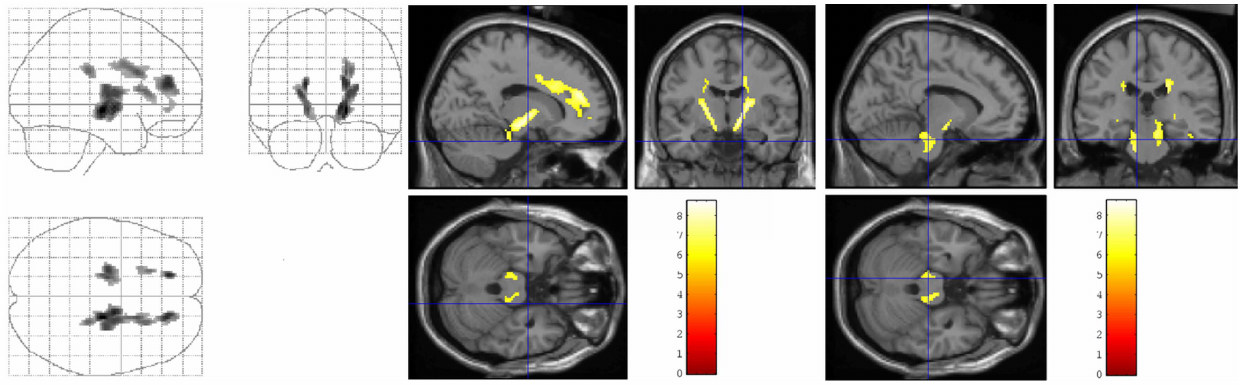
Figure 2. Brain regions in which microstructural lesions were associated with the severity of CSR in patients with CSA. SPM ‘‘glass brain’’ presentation (left) and statistical FA maps that were superimposed on a normalized T1-weigthed template (middle and right) showing symmetric clusters of correlation between relative CSR length and decreased FA values in the upper brainstem and in frontal WM as well as in connecting fibres between both areas (p , 0.001, minimum of 50 continuous voxels; corrected for multiple comparisons). Coloured bars represent t- values; display threshold is set at t-value . 3.71. CSR=Cheyne-Stokes Respiration; CSA=Central Sleep Apnea; SPM=Statistical Parametric Mapping; FA=Fractional Anisotropy.